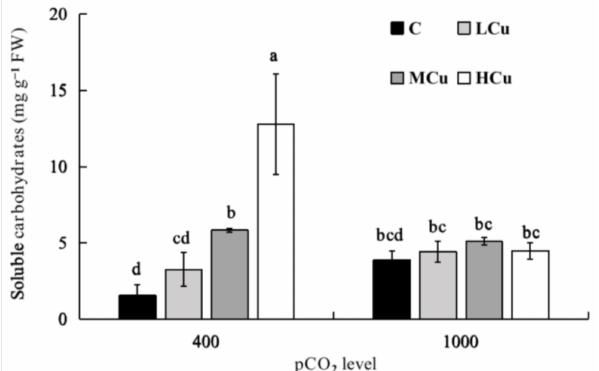
Figure 4. Soluble carbohydrate contents of S. japonica grown at different pCO 2 levels and copper concentrations. C (control, natural seawater); LCu (low copper concentration, 0.2 µ M); MCu (medium copper concentration, 0.5 µ M); HCu (high copper concentration, 0.2 µ M). All results are shown as mean value ± SD ( n = 3). Different letters indicate statistical differences ( p < 0.05) among experimental